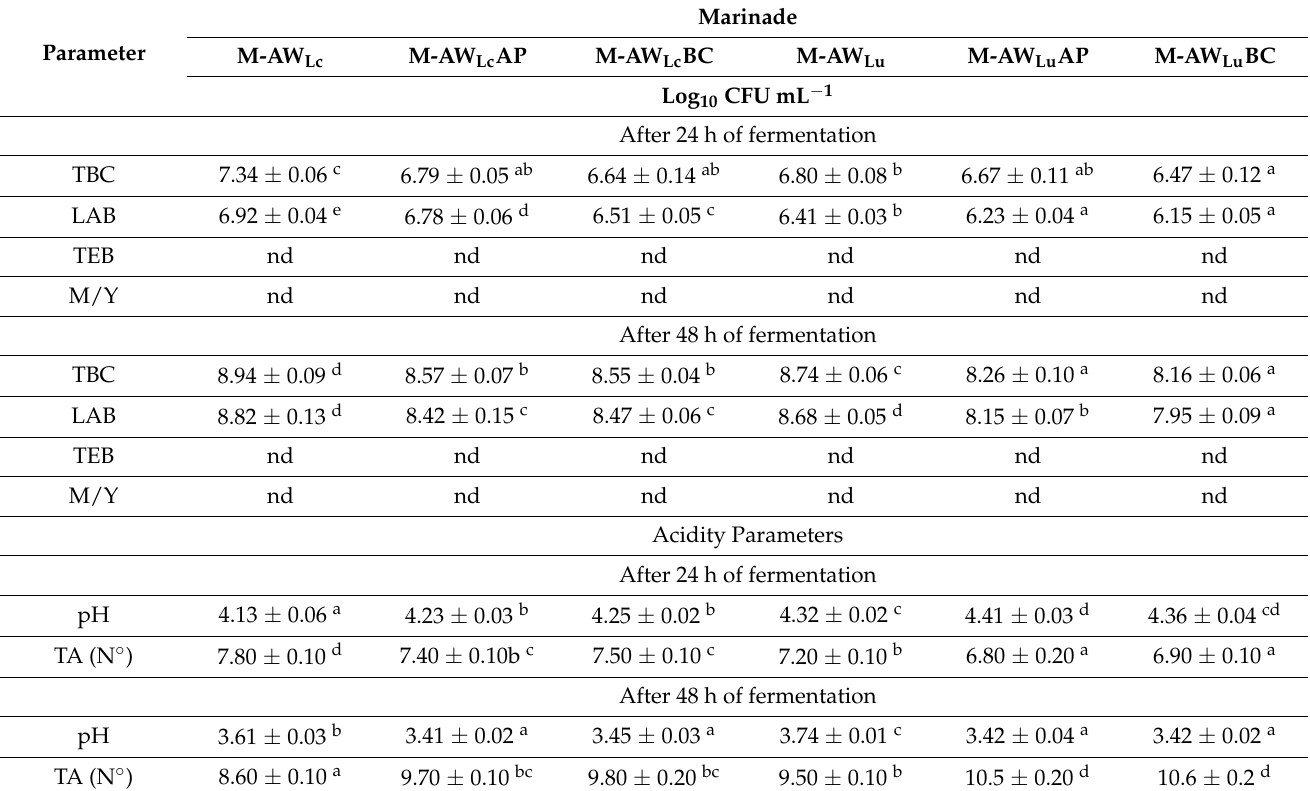
Table 3. The acidity and microbial parameters of the